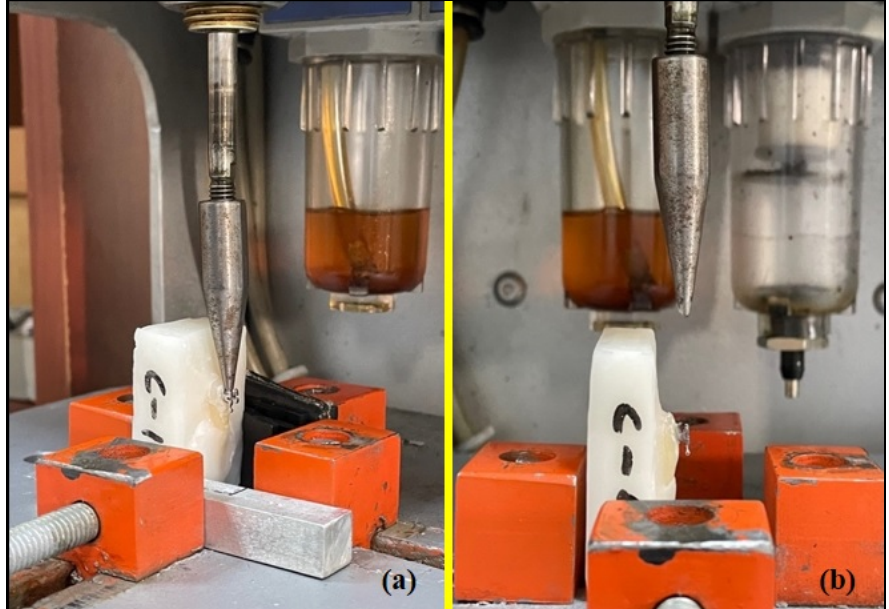
Figure 3. Checking the angle between the bracket groove and the metal nozzle tip from the lateral ( a ) and from the frontal ( b ).